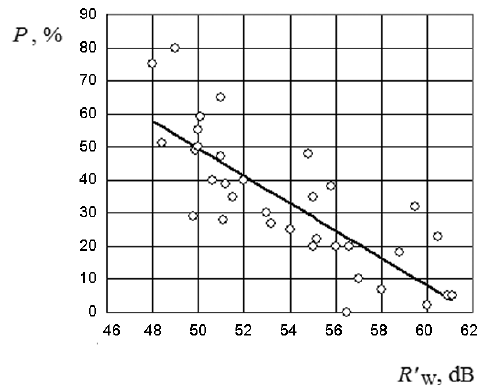
Fig. 5. Percentage of the occupants which evaluated their acoustic comfort level as poor depending on the vertical partition’s (wall) weighted apparent sound reduction index R ’ w value (modified from Jagniatinskis 2003)